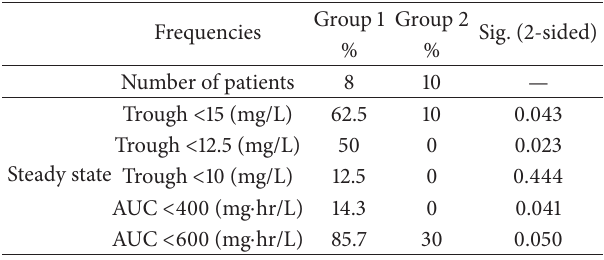
AUC: area under the